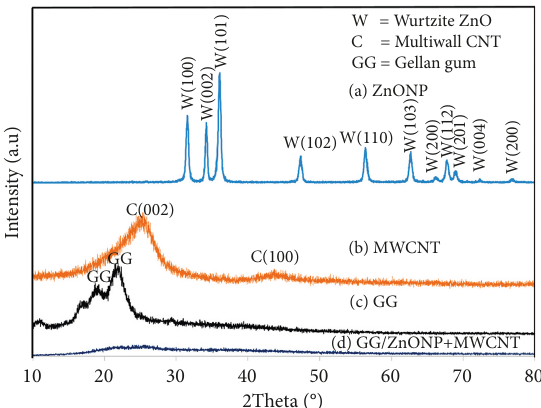
Figure 2: XRD pattern of (a) ZnONP, (b) MWCNT, (c) GG film, (d) GG/ZnONP+MWCNT bionanocomposite